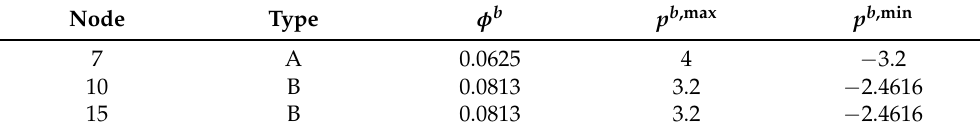
Table 3. BESS information.